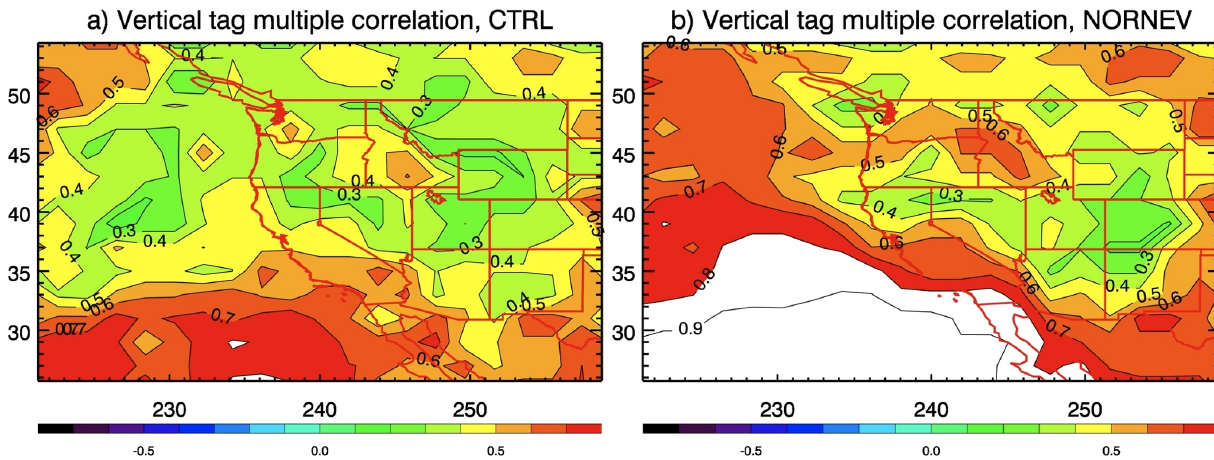
Figure 5. ( a ) Multiple correlation between tags 2–6 ( p simulation; and ( b ) the NORNEV simulation.